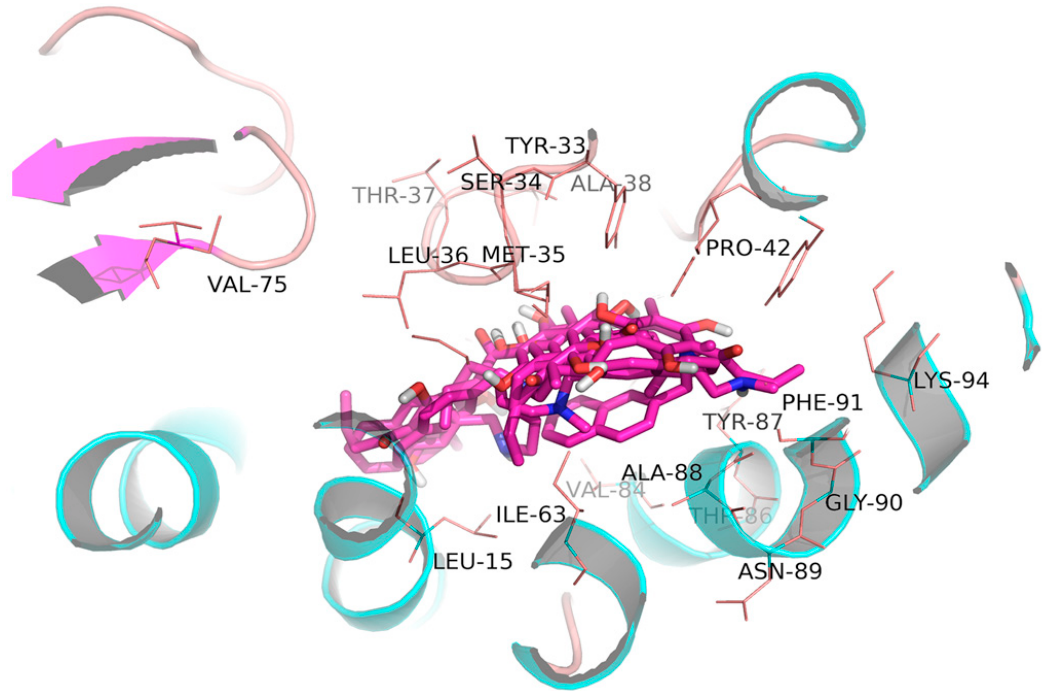
Figure 4. Binding modes of compounds 13 – 17 with 2AIB. The structural framework of compounds was marked with amaranth color. Protein skeleton of 2AIB was marked with green color. The atoms involved in the path are identified as colored stick. (Oxygen (orange), nitrogen (blue), hydrogen in hydroxyl